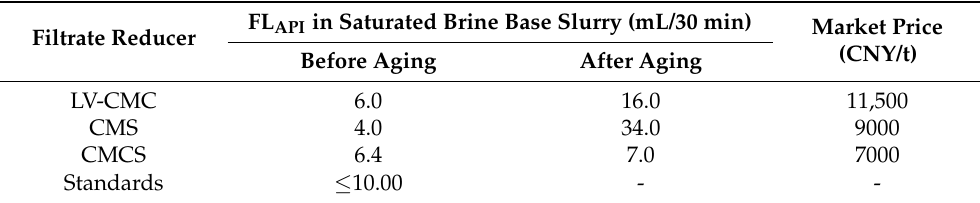
Table 2. Contrast of LV-CMC, CMS, and CMCS according to the standards in the specification of drilling fluid materials.